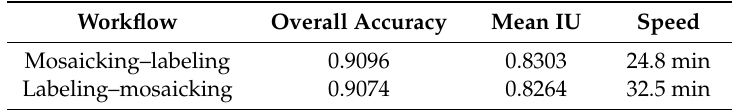
Table 2. Experimental results of different workflows. The speed was measured using the total time required to generate the weed cover map for the whole field, including data collection and data processing. Mean IU-mean intersection over union.